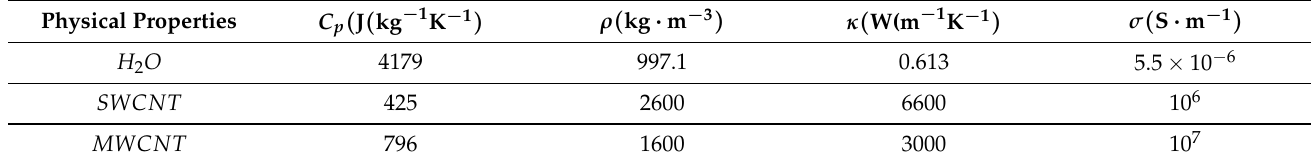
Figure 1. Physical configuration with coordinate system. Table 1. Thermophysical properties of H 2 O and CNTs [56,57].